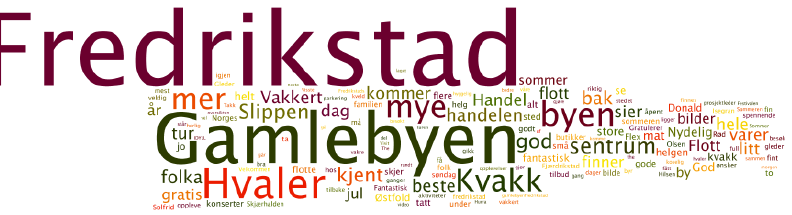
Figure 5. Word Figure 5. Word cloud.